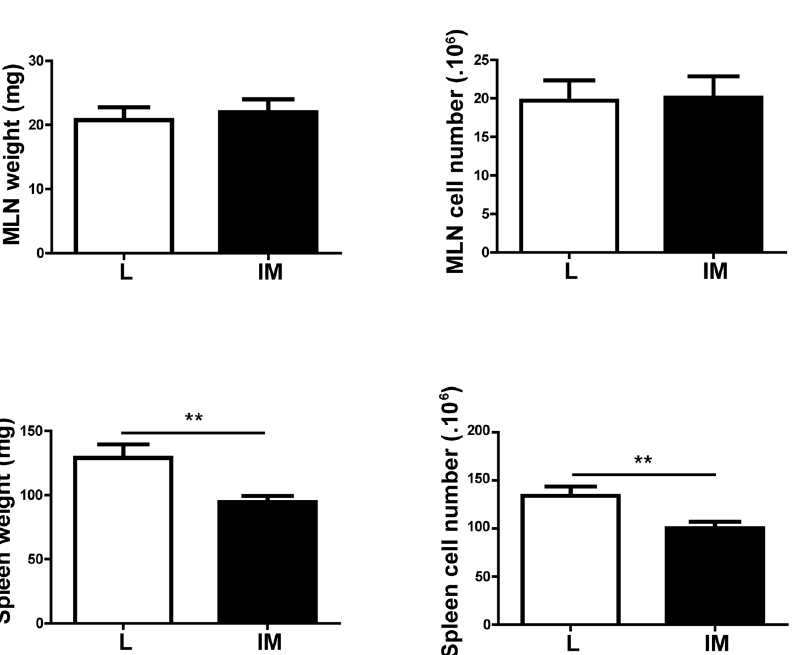
Figure 2. The spleen but not the MLN responds to Intestinal manipulation 24 h after surgery. (A) IM leads to a significant decrease in spleen weight and splenocyte number (B) but doesn’t affect the weight or cell number in MLN. Data shown are mean 6 SEM of 3 independent experiments (n=12 animals per group). **p , 0.01 (Student t-test).